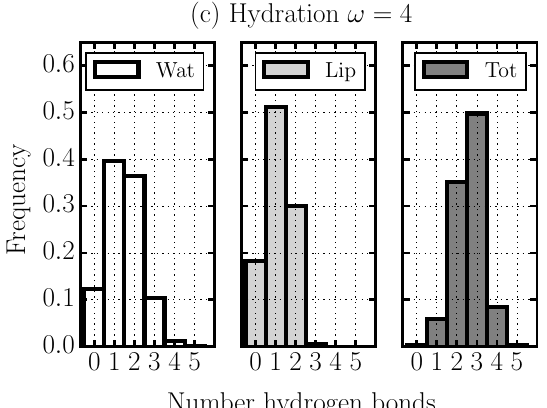
Figure 5. Normalized distributions of the number of HBs per water molecule in stacked membranes for ( a ) ω = 34; ( b ) ω = 10; and ( c ) ω = 4. At each hydration level, we present the normalized distribution of water molecules forming a given number of HBs 5 with other water molecules ( left ), with lipid ≤ groups ( center ), and the normalized distribution of the sum of the two kinds of HBs ( right ).